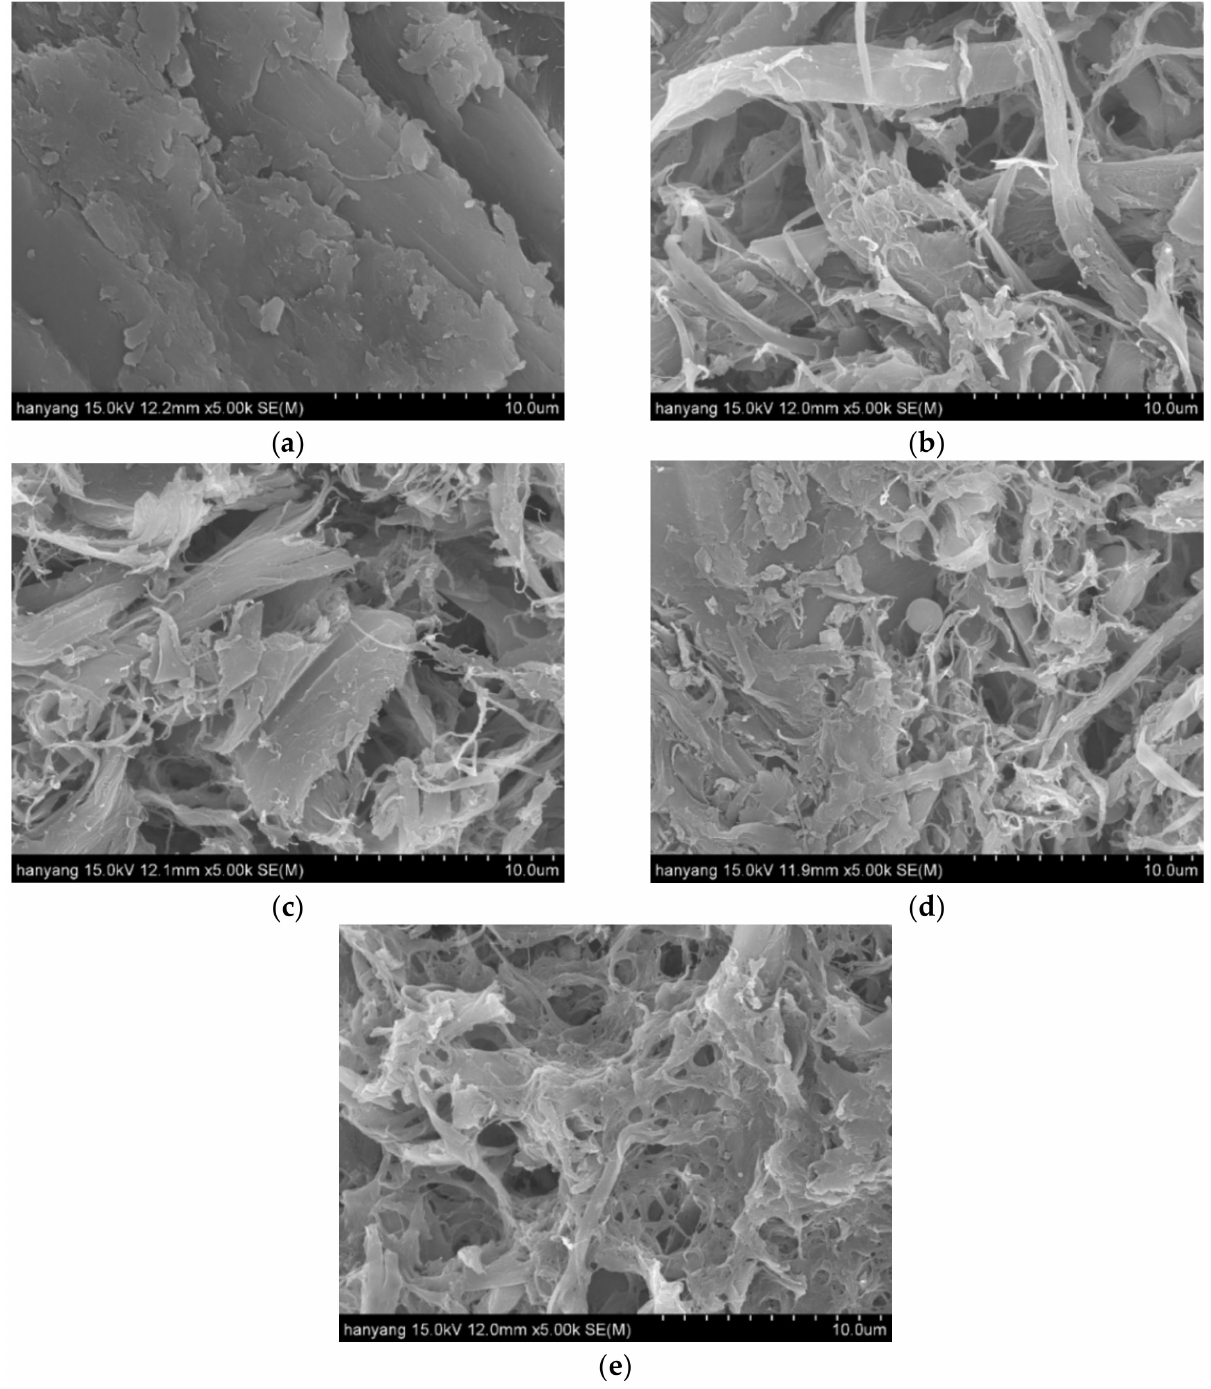
Figure 2. SEM images of untreated and CM-treated oak wood under 5000 × magnification, ( a ) untreated oak wood, ( b ) CM-treated oak wood (3 h), ( c ) CM-treated oak wood (6 h), ( d ) CM-treated oak wood (9 h), and ( e ) CM-treated oak wood (12